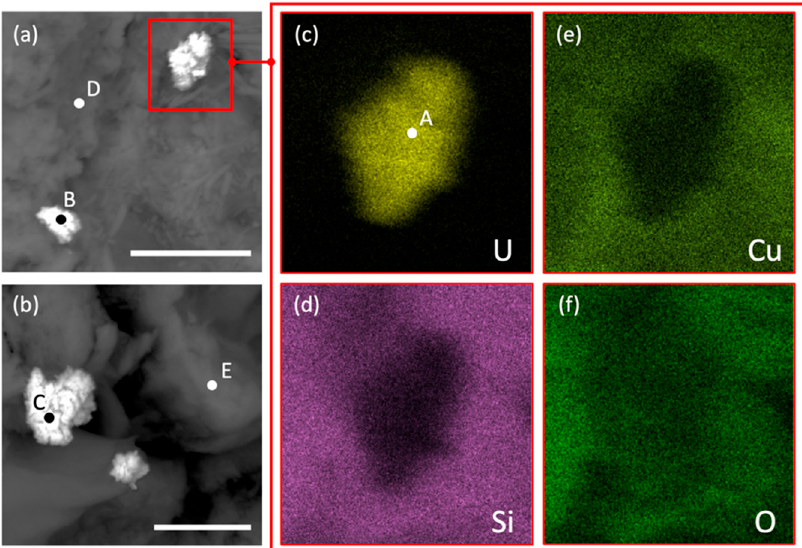
Figure 6. ( a ) and ( b ) Mixed Backscattered electron (BSE) and Secondary electron (SE2) images showing a typical U composition (high Z number) mineral grain (white) against the surrounding (low Z number) matrix (dark), EDS compositional maps of the mineral grain identified in ( a ), detailing the distribution of ( c ) U, ( d ) Si, ( e ) Cu, and ( f ) O. Scale bars = 5 µm. The locations at which EDS point analysis results (A–E) were also obtained and identified, as shown in Figure 7.